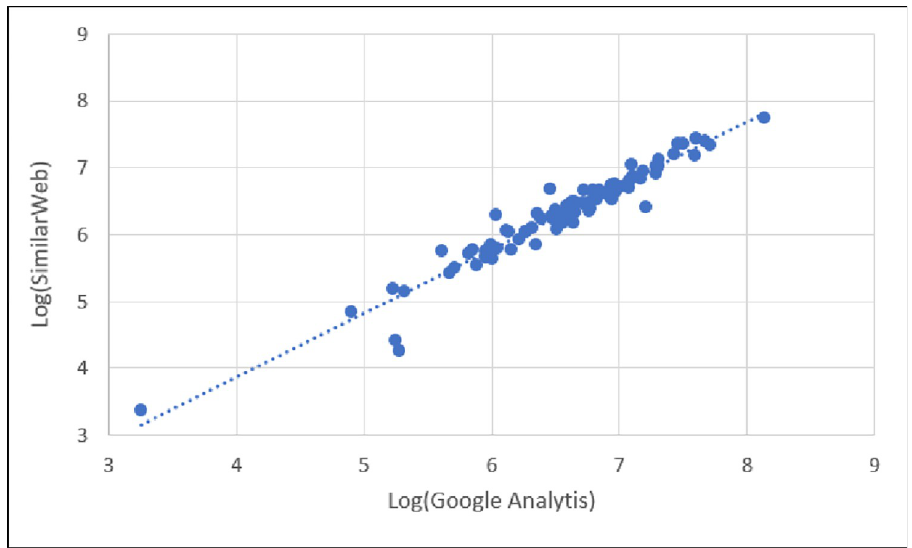
Fig 3. Scatter plot of unique visitors reported by Google Analytics and SimilarWeb showing strong, positive, linear correlation.